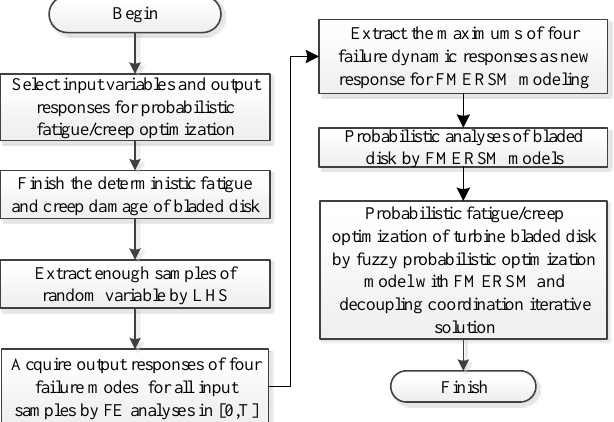
Figure 1. Flow chart of reliability optimization based on the fuzzy multi-extremum response surface method (FMERSM) method.